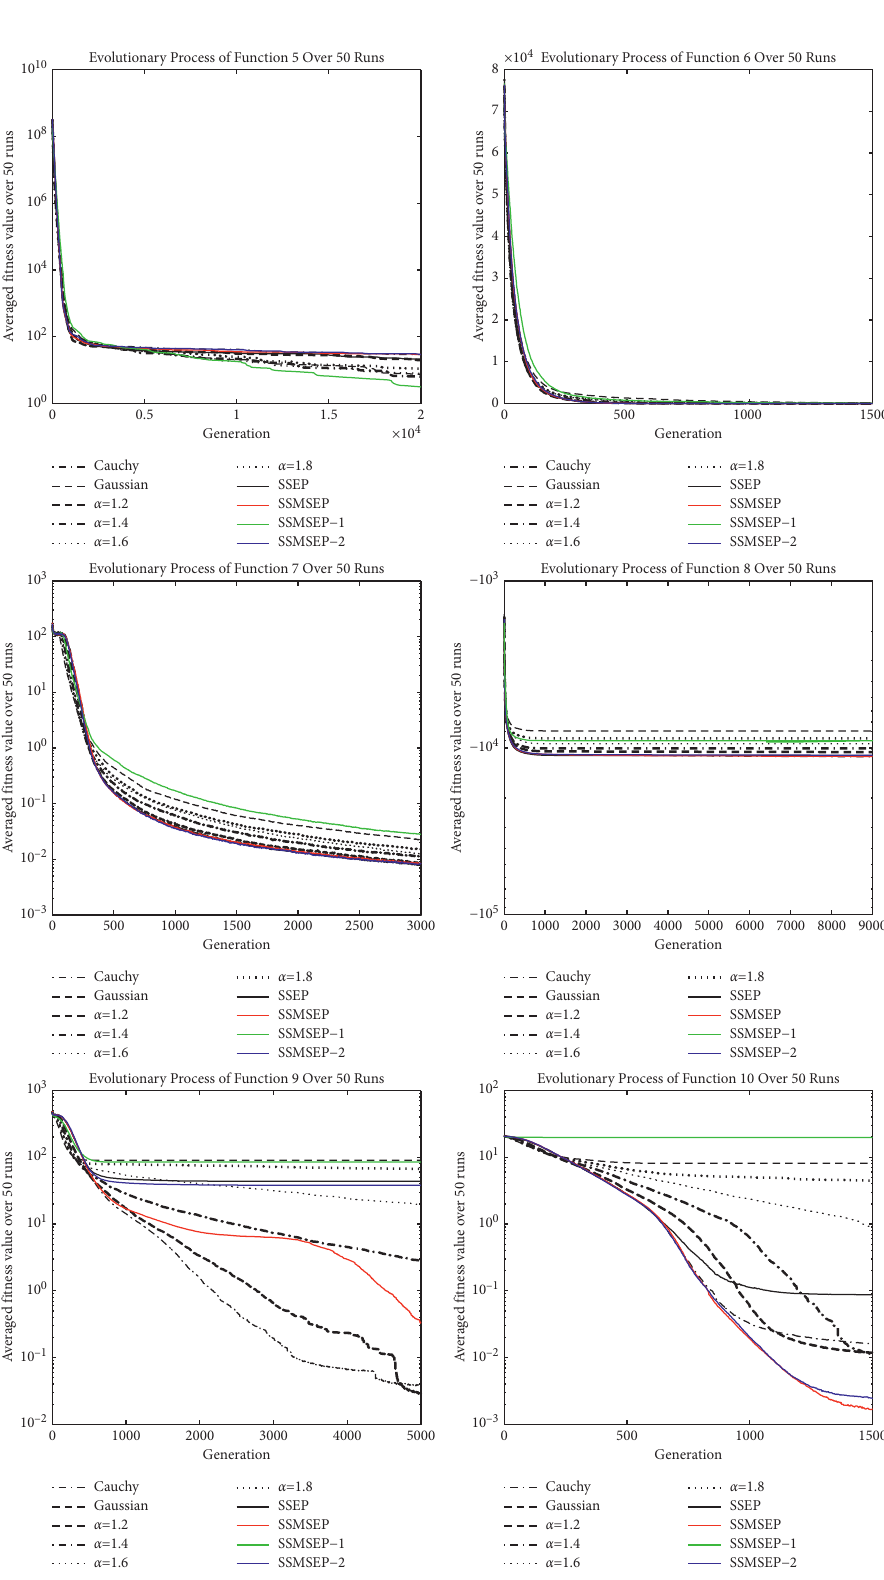
Figure 2: Evolutionary process of f